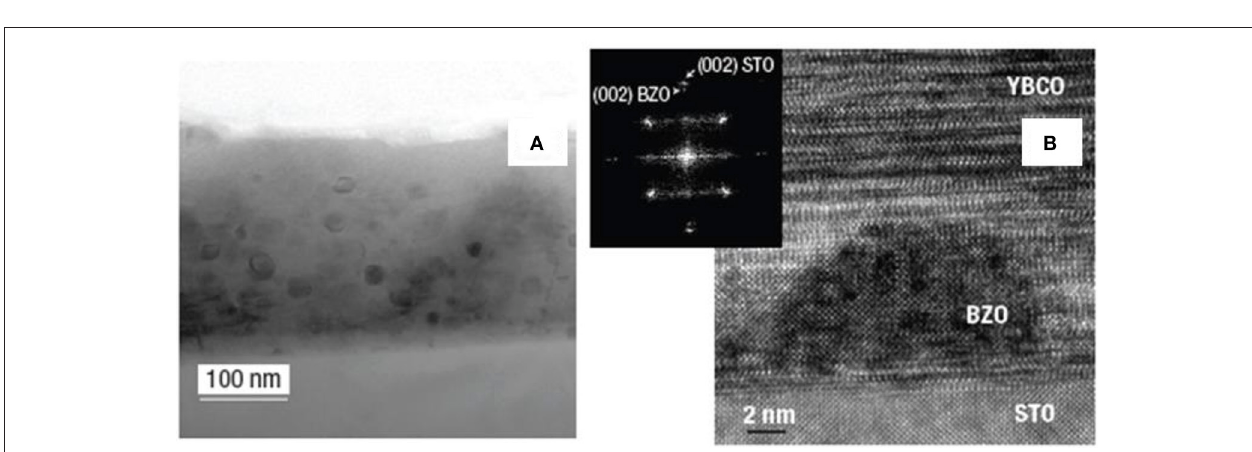
FIGURE 8 | (A) Cross-sectional TEM image of a YBCO:BZO nanocomposite film in which BZO nanoparticles can be clearly observed. (B) High-resolution TEM image of a BZO nanoparticle grown near the interface with the single-crystal substrate. Inset shows the fast Fourier transform of the image in which the epitaxial relationship between BZO and YBCO can be seen in the diffraction peaks. Reprinted from Gutierrez et al. [86], with the permission from Springer Nature © (2007).